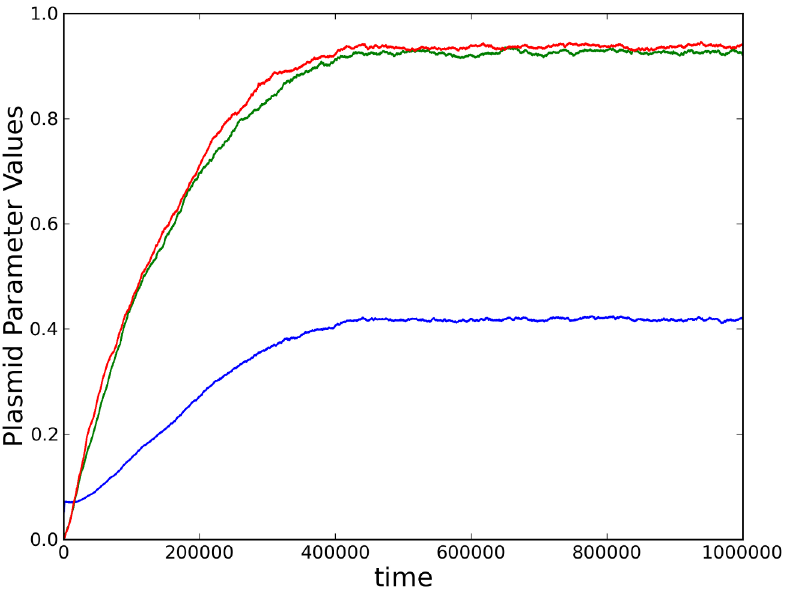
Figure 6. The co-evolution of policing, obedience and baseline reproduction. Average plasmid parameter values b (blue), k (green) and a (red) over time, showing the evolution of the CNC mechanism in stochastic multicellular simulations, with mutation probability m ~ 10 { 2 . Results have been averaged across 50 independent simulations with the same initial conditions.